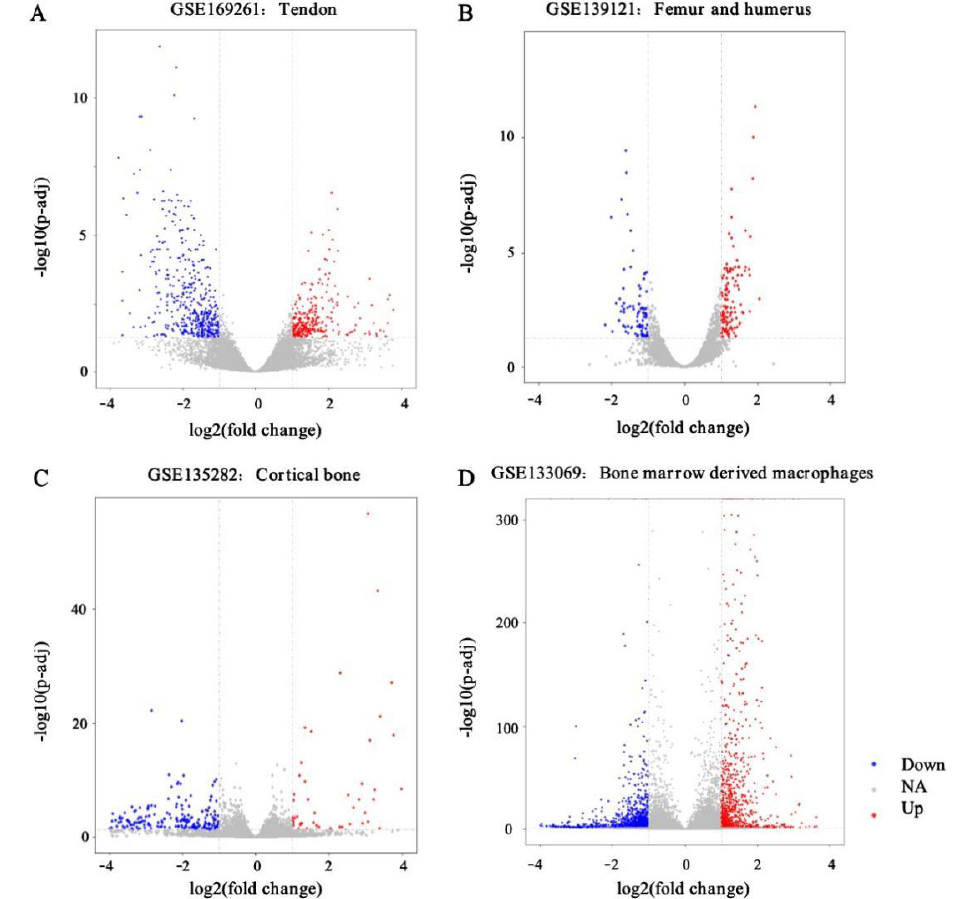
Figure 1. Gene expression profiles of GSE169261 ( A ), GSE139121 ( B ), GSE135282 ( C ), and GSE133069 ( D ) are visualized in volcano plots. DEGs are marked with red, and the criteria for a DEG are |log2FC| > 1.